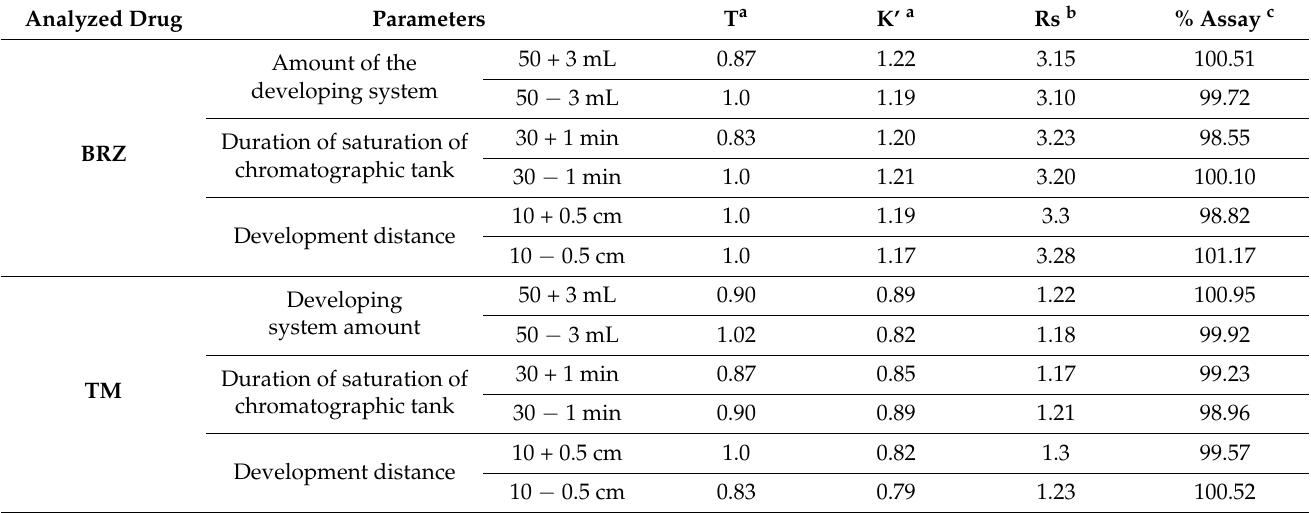
Table 3. Data for robustness for the TLC-Densitometric Method (MI).